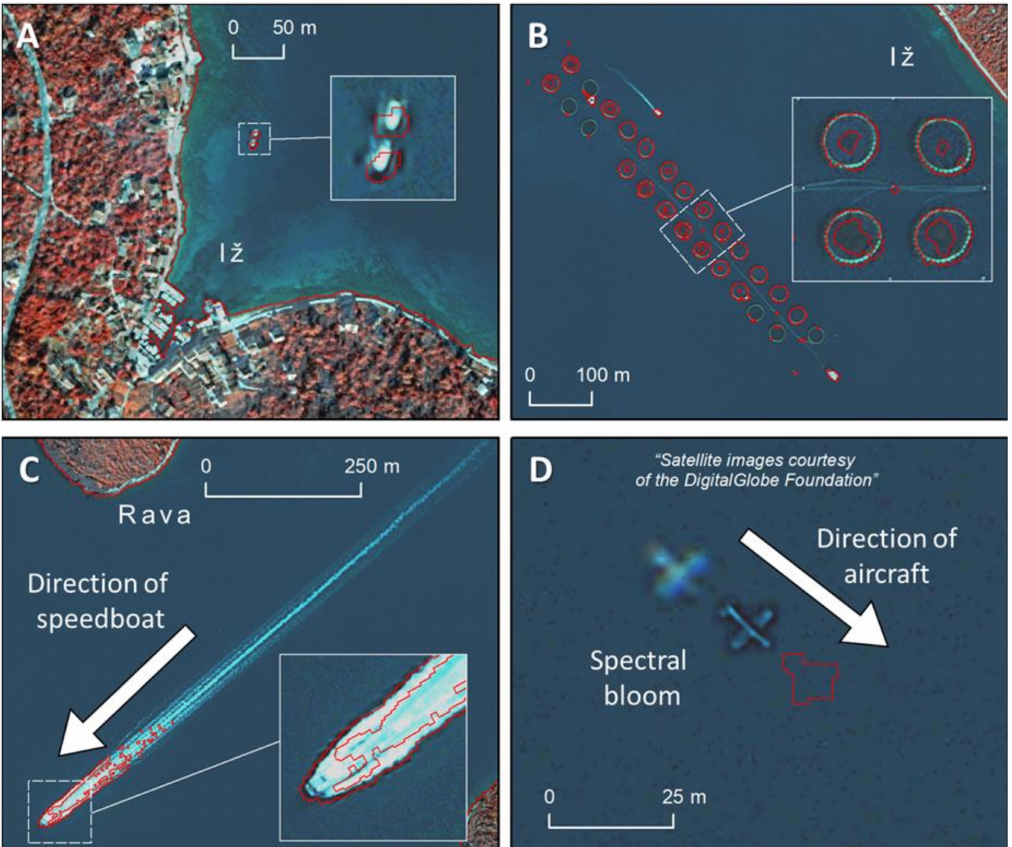
Figure 14. Example of CET application for the detection of small boats ( A ); the detection and mapping of fish farms ( B ); the detection of speedboats ( C ); the detection of aircrafts ( D ). Spectral bloom is caused by fast-moving objects due to temporal offset of the multispectral sensors of the WV-2 satellite. It can be used for determination of the speed of moving objects